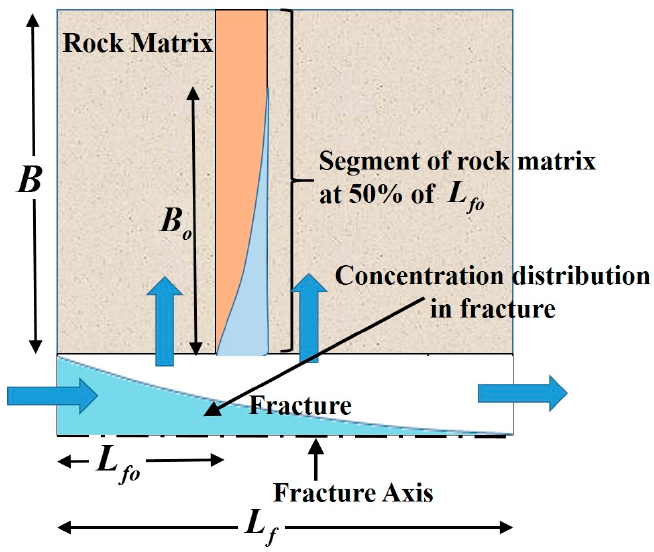
Figure 2. Schematic representation of parameters that are used to calculate “Rock Saturation Factor”.